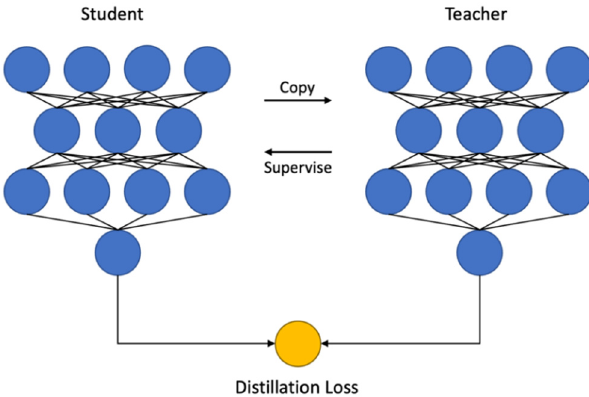
Figure 4. Example of structured knowledge distillation.